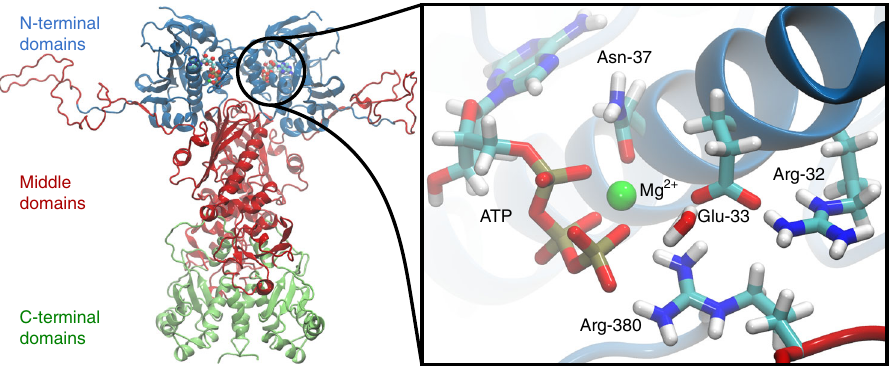
Fig. 1 Structure of the yeast Hsp90 dimer (PDB ID: 2CG9) 9 . The N-terminal domains of Hsp90 are shown in blue, the middle domains in red, and the C- terminal domains in green. The inset shows a structure of the active site with a bound ATP molecule obtained from an MD simulation, where Asn-37 undergoes a rotation to form a stronger coordination to the